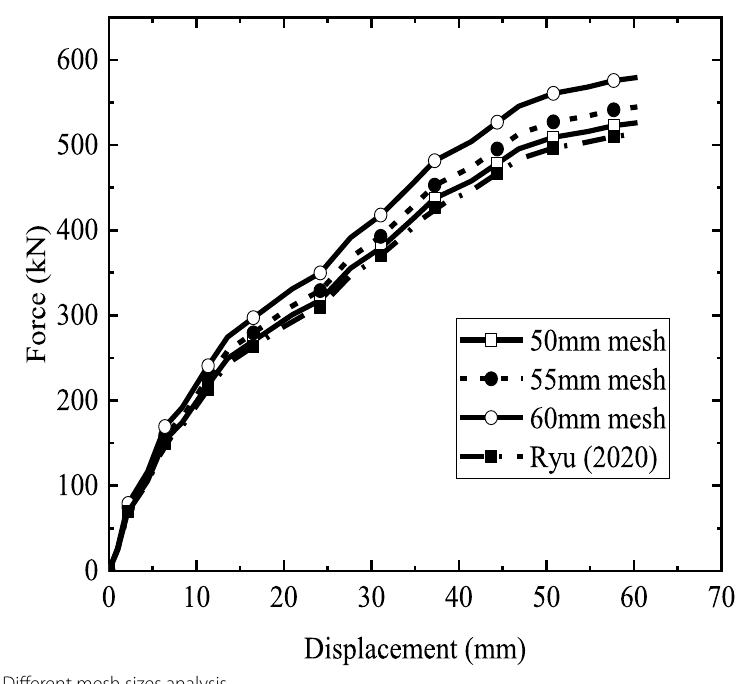
Fig. 9 Different mesh sizes